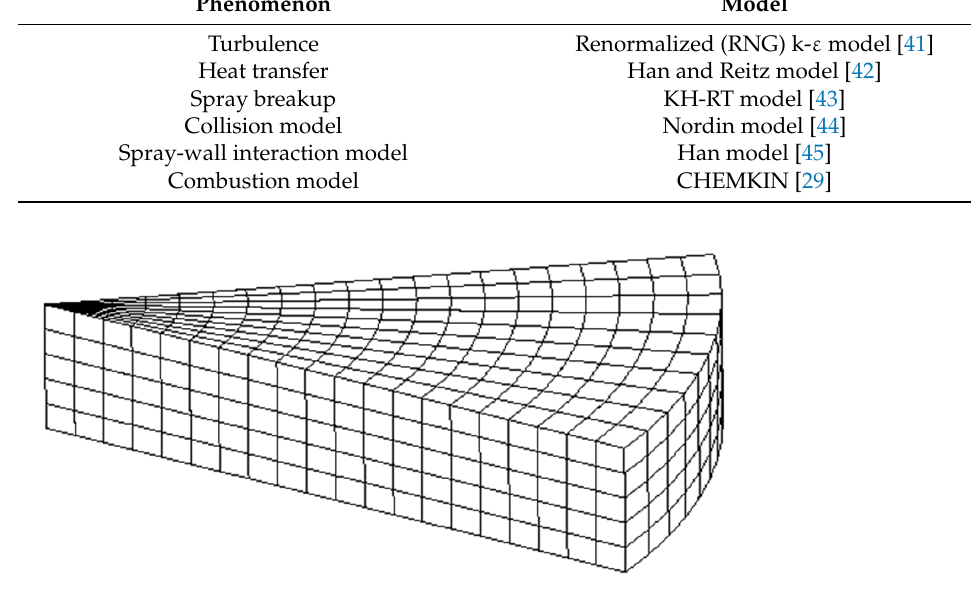
Figure 16. Computational mesh.